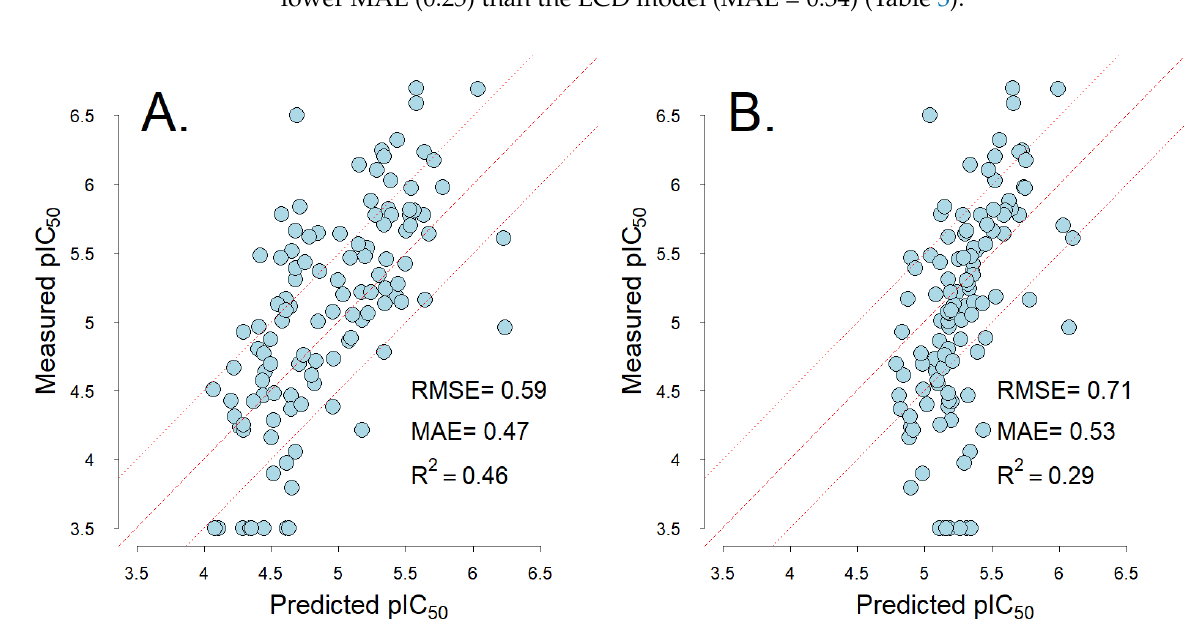
Figure 2. The relationship between predicted and measured pIC 50 hERG inhibition estimates. The predictions are from the ECD model ( A ) and LCD model ( B ). The dashed line shows one-to-one correlation and the dotted lines mark 0.3 pIC50 errors around one-to-one correlation.